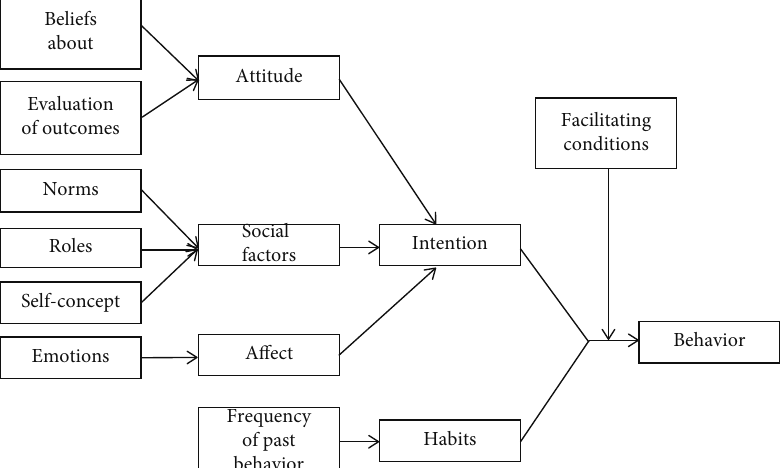
Figure 3: Theory of interpersonal behavior [26,